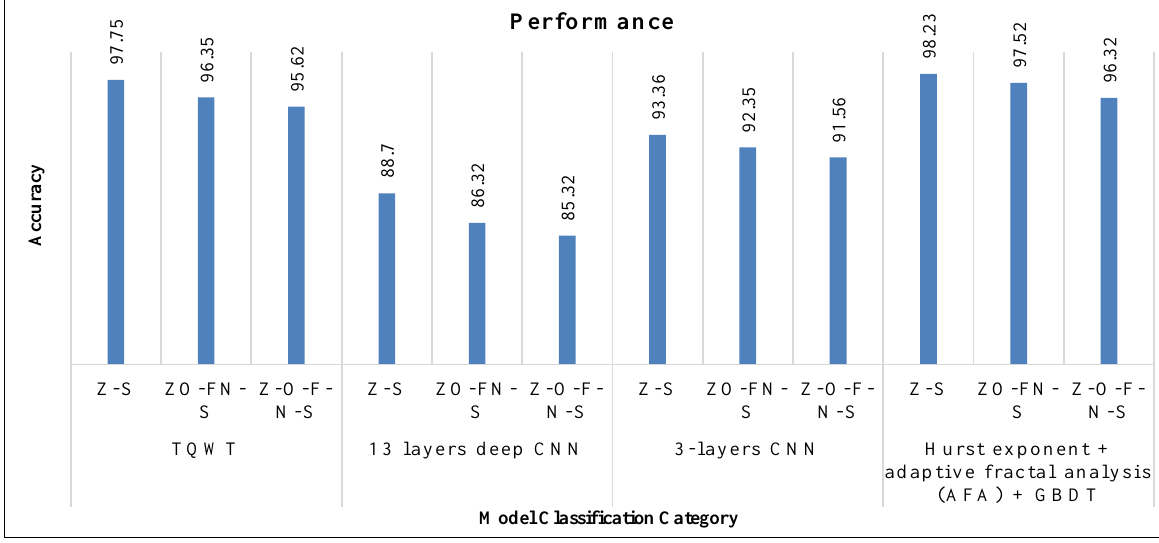
Figure 5. The accuracy of existing and proposed